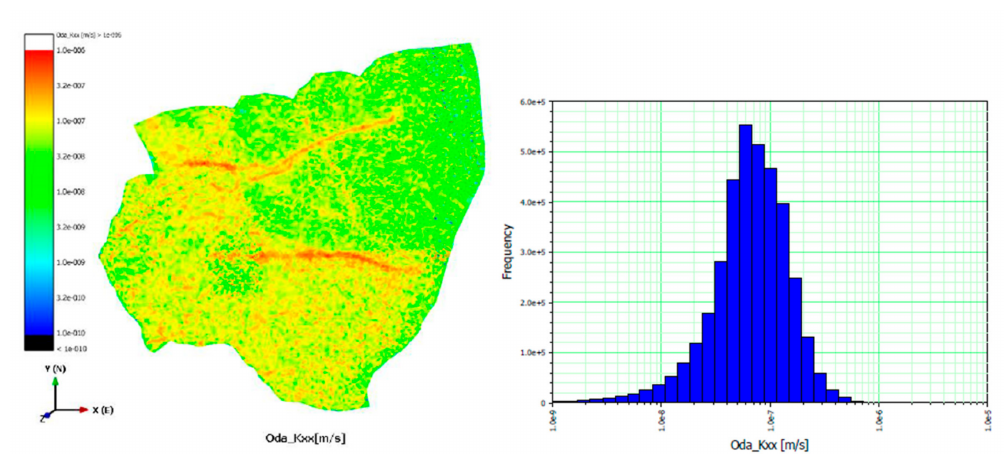
Figure 11. Upscaled hydraulic conductivity tensor in x-direction, K xx [m/s].